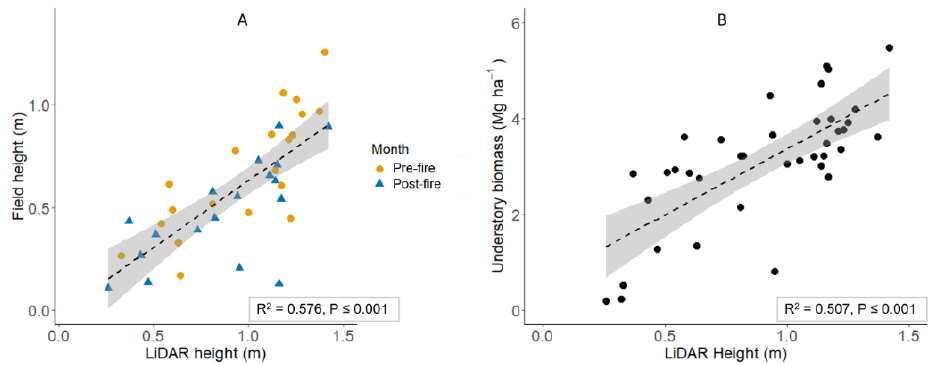
Figure 6. ( A ) Comparison between field understory height (m) and LiDAR understory height (m) for two sample dates that fell before (May 2018) and five months after (November 2018) a prescribed fire. ( B ) Relationship between LiDAR height (m) and understory biomass (Mg ha − 1 ) along with the confidence interval of the regression